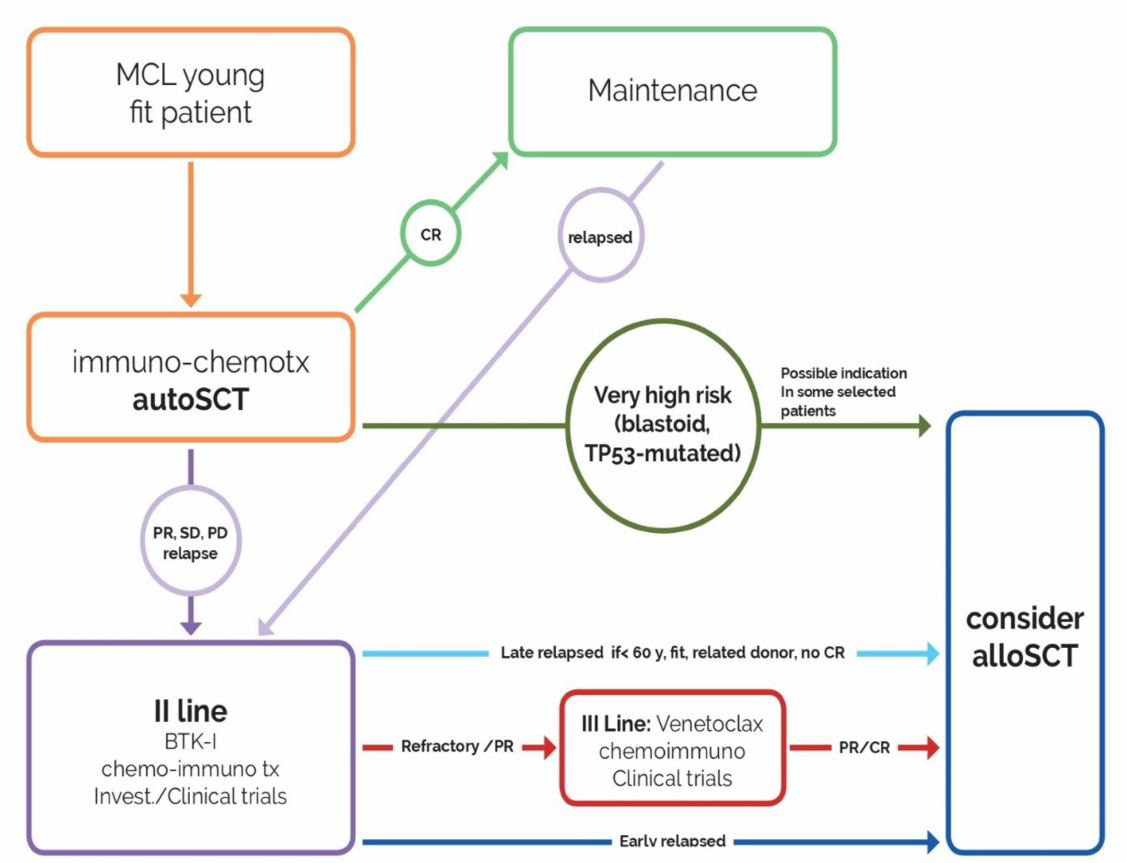
Figure 1. Therapeutic strategies in Mantle Cell Lymphoma (MCL) and positioning of